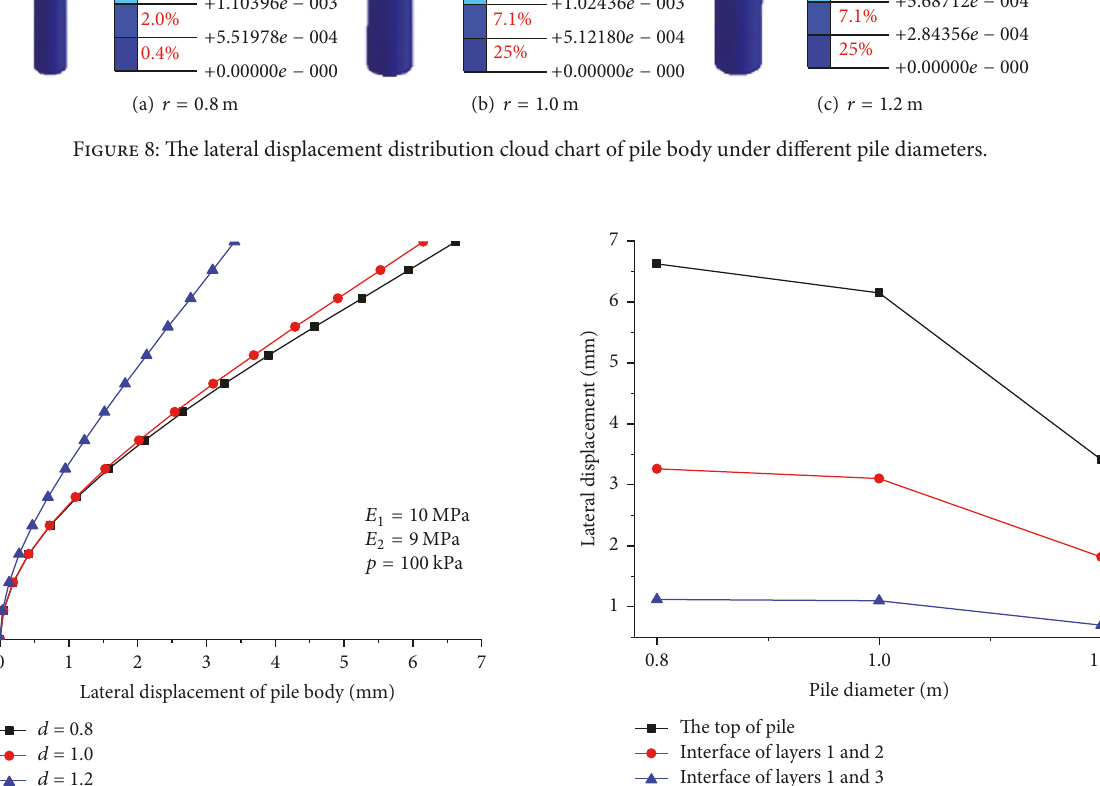
Figure 10: Relationship between lateral displacement and pile diameters at different